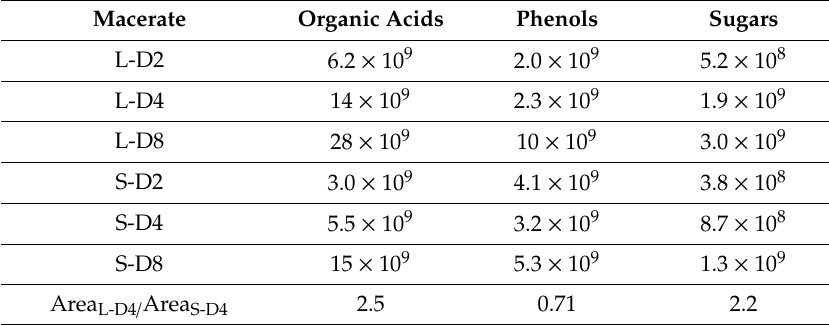
Table 2. Sum of UHPLC-HRMS peak areas for major classes of constituents in macerates prepared with leaves collected from trees exposed to solar light (L-D2, L-D4, and L-D8) and leaves collected in trees facing north (S-D2, S-D4, and S-D8) after 2, 4, and 8 days of maceration. Area L-D4 / Area S-D4 represents the ratio of peak areas for L-D4 over S-D4.